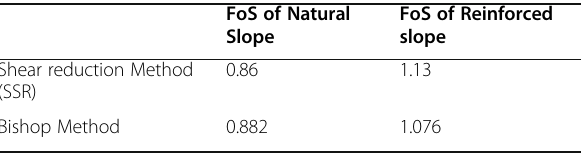
Table 2 Difference of factor of safety by finite element method and limit equilibrium